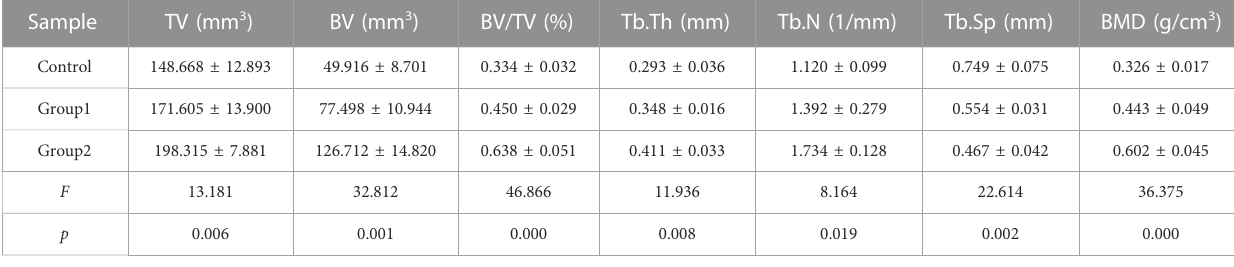
TABLE 1 Micro-CT parameters of rat femora at week 8 (Mean + SD).